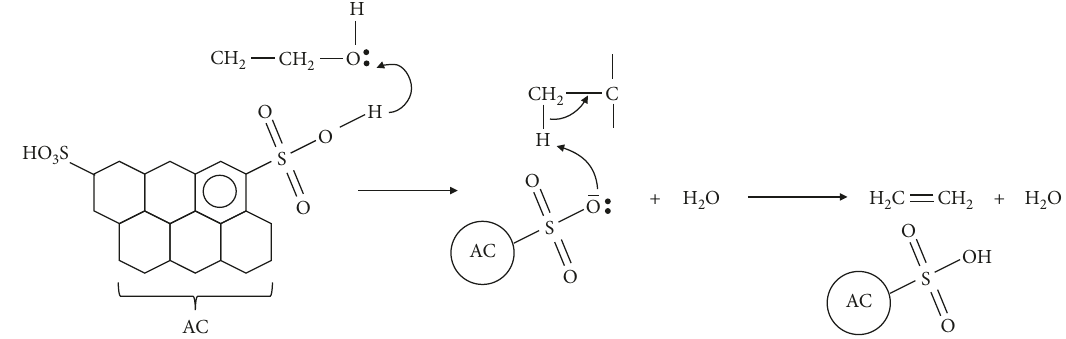
Figure 6: The mechanism of ethanol dehydration to